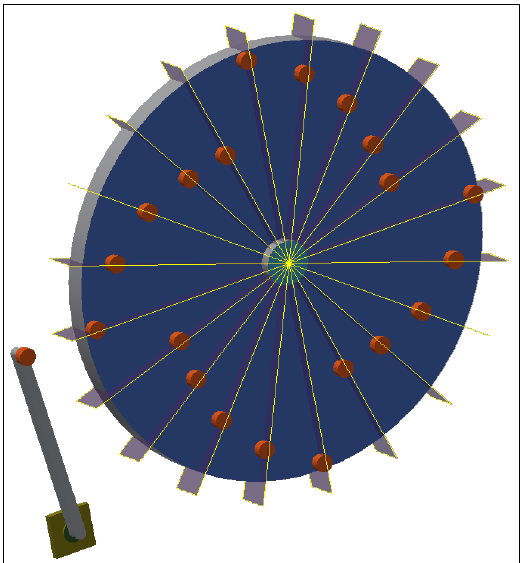
Figure 9. Repeated sequence variant of contactless magnets crank-rocker